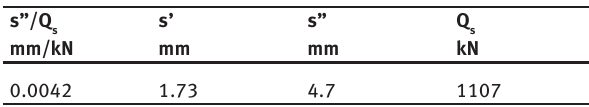
Table 2: Output parameters according to correlations from Fig. 4 to Fig.